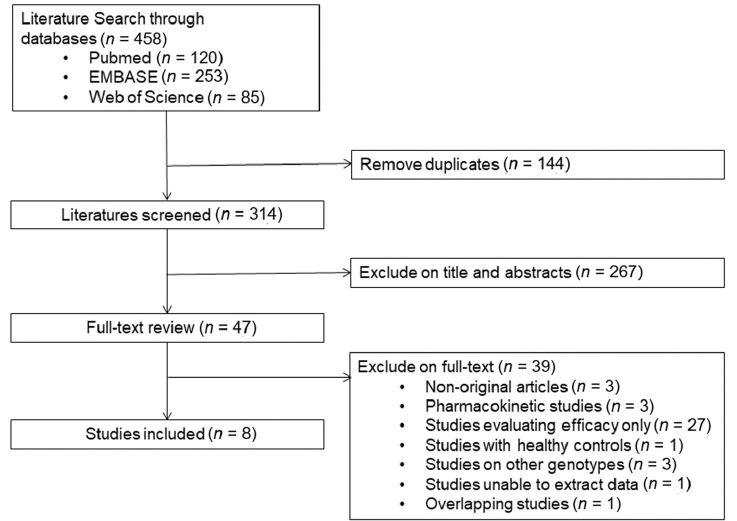
Figure 1. Flow diagram of study selection.